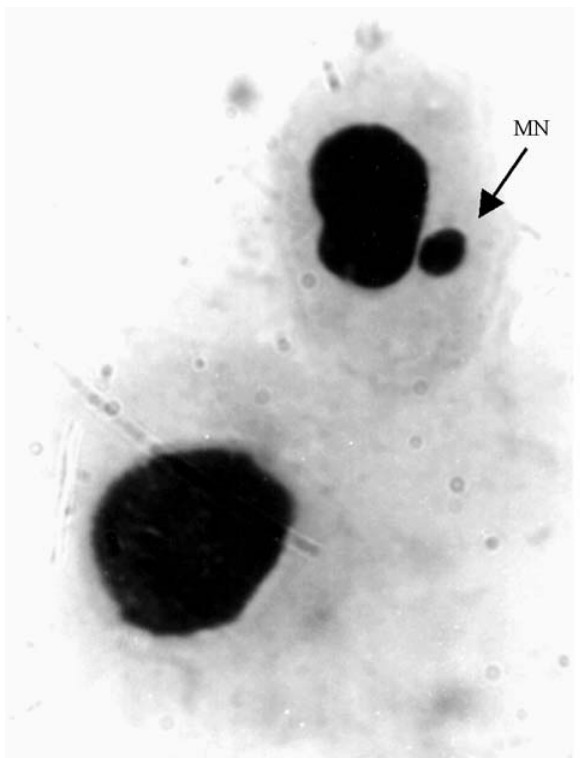
Figure 3 - Micronucleated erythrocyte (arrow) in R. Catesbeiana tadpole exposed to lambda-cyhalothrin. Giemsa-stained blood smear 1,000